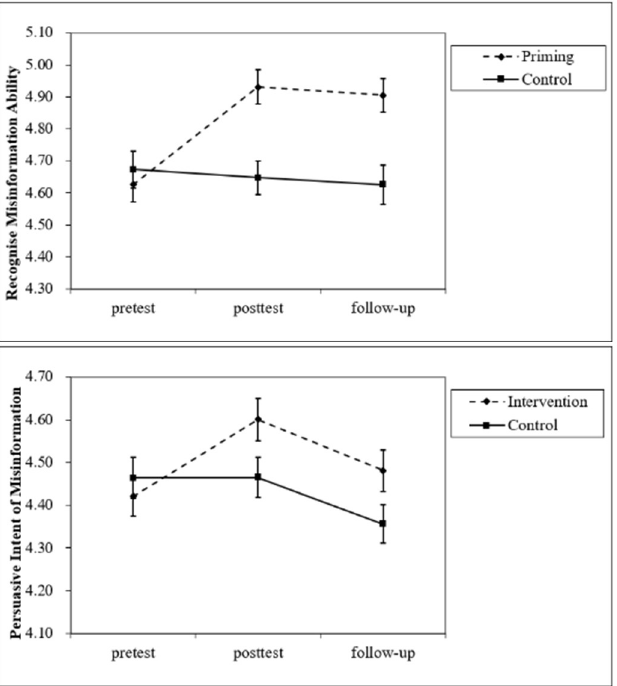
Figure 1. Interaction effect between group and time on misinformation discrimination in Study